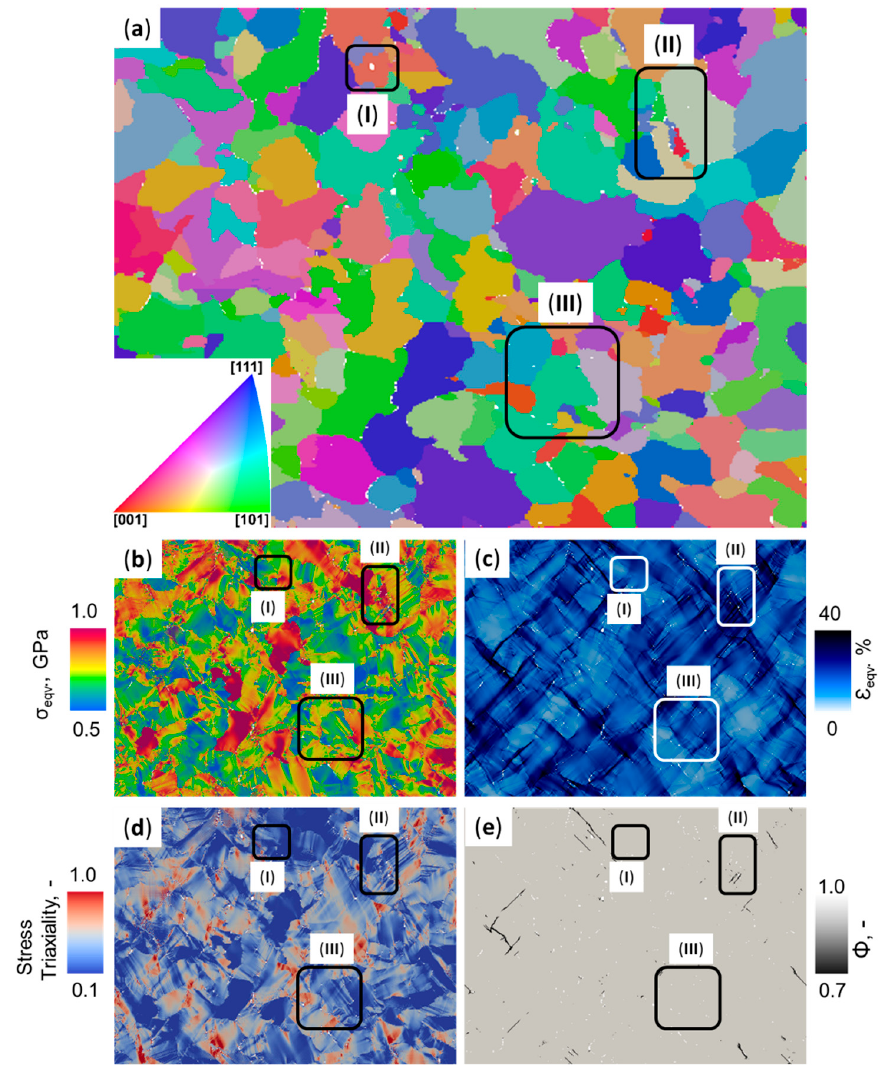
Figure 10. A construction figure with ( a ) showing the selected RVE with the identification of three zones. All non-metallic inclusions are displayed by white points. In other subplots, ( b ) true Mises stress, ( c ) true Mises strain, ( d ) stress triaxiality, and ( e ) damage propagation withing the ferrite matrix are shown. Zone-I has a ferrite grain with a large MnS inclusion in the middle, zone-II is a region of small ferrite grains with clustered non-metallic inclusions present on the grain boundaries, and zone-III has relatively large ferrite grains with a dispersed distribution of non-metallic inclusions within grains and on the grain boundaries. The loading axis is horizontal to the